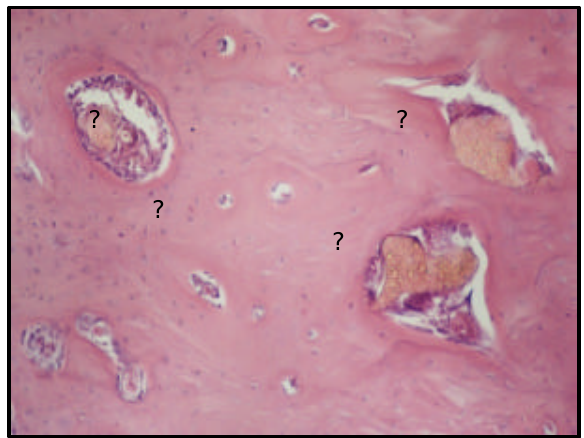
FIGURA 2 - Tecido ósseo imaturo ( ? ) rodeando fragmentos do polímero ( ? ). HE 350x